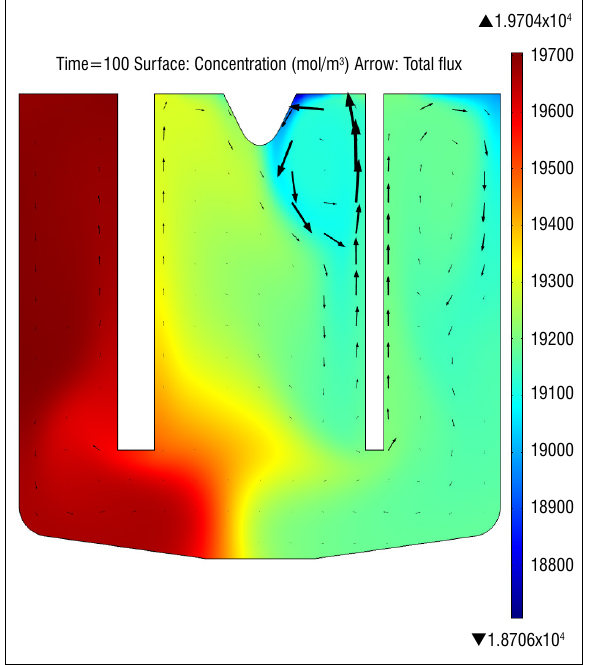
Figure 8: Dissolved hydrogen fluoride concentration and flux